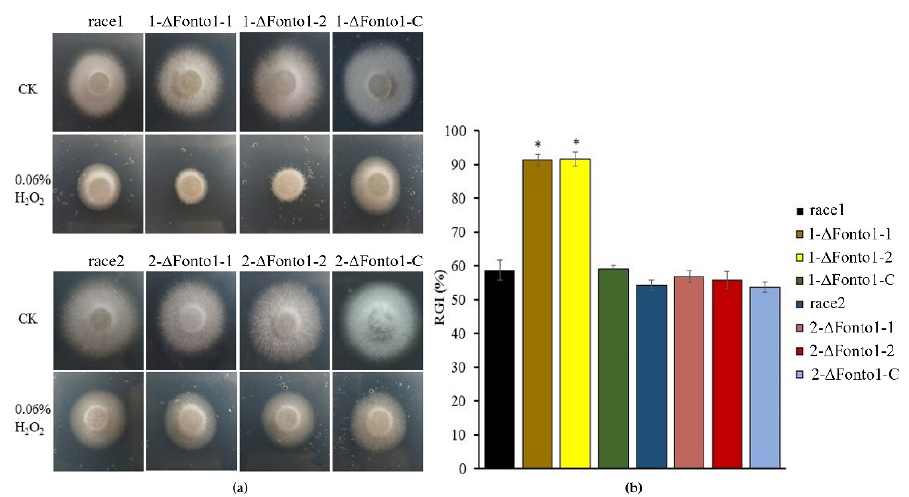
Figure 5. Sensitivity to oxidative stress. ( a ) Colony morphology of race 1, race 2 and their corresponding Nto1 deletion mutants (1- ∆ Fonto1-1, 1- ∆ Fonto1-2, 2- ∆ Fonto1-1 and 2- ∆ Fonto1-2) and complementation mutants (1- ∆ Fonto1-C and 2- ∆ Fonto1-C) after 4 days of inoculation on PDA amended with 0.06% H 2 O 2 . Three replicates were performed for each race; ( b ) mycelial radial growth